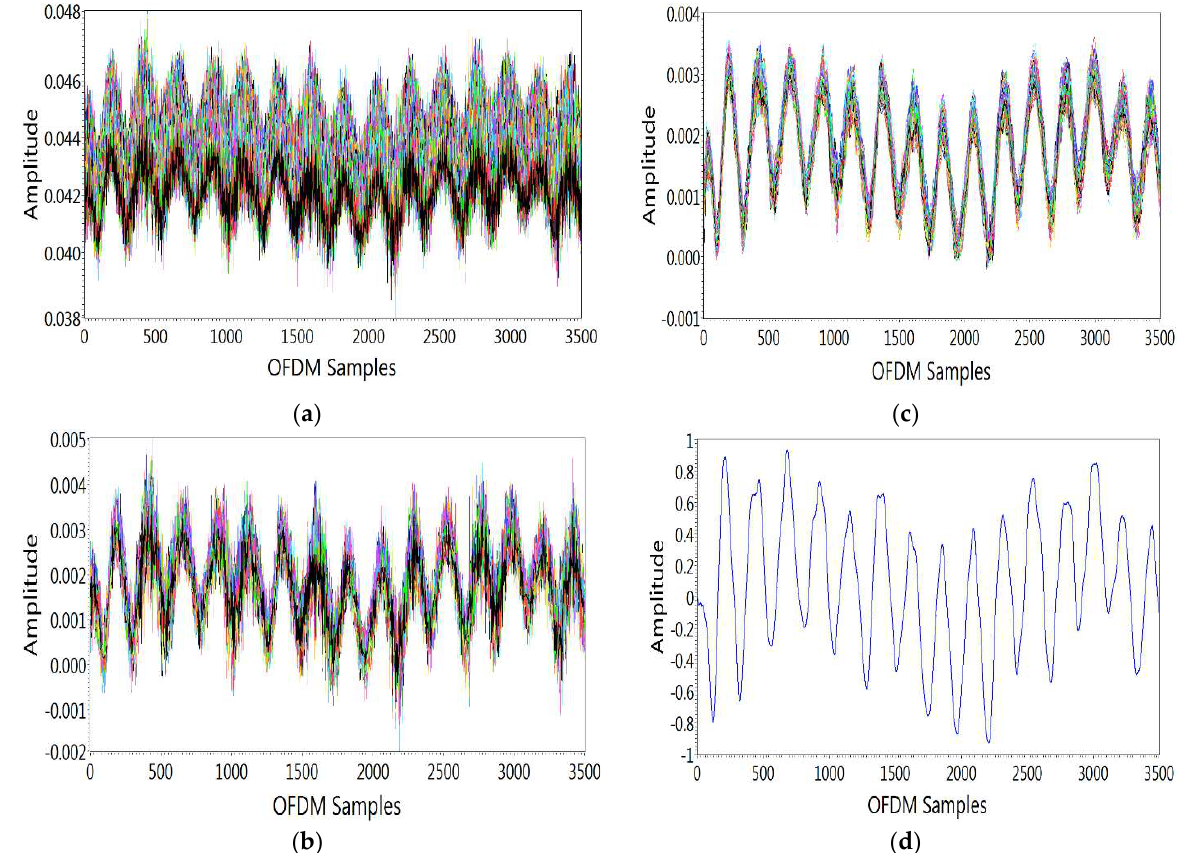
Figure 4. Data preprocessing layer. ( a ) Subcarrier selection, ( b ) Outliers removal, ( c ) data smoothing, ( d ) data normalization.